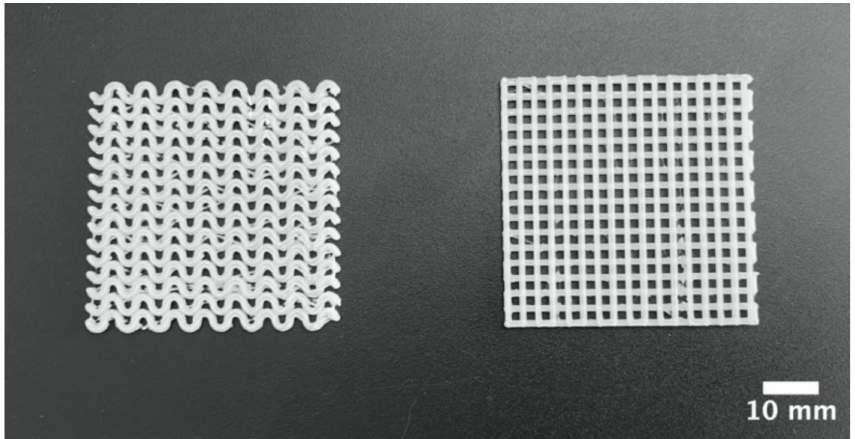
Figure 2. Macrostructure of ellipsoidal and square pore shape PLA pieces obtained through